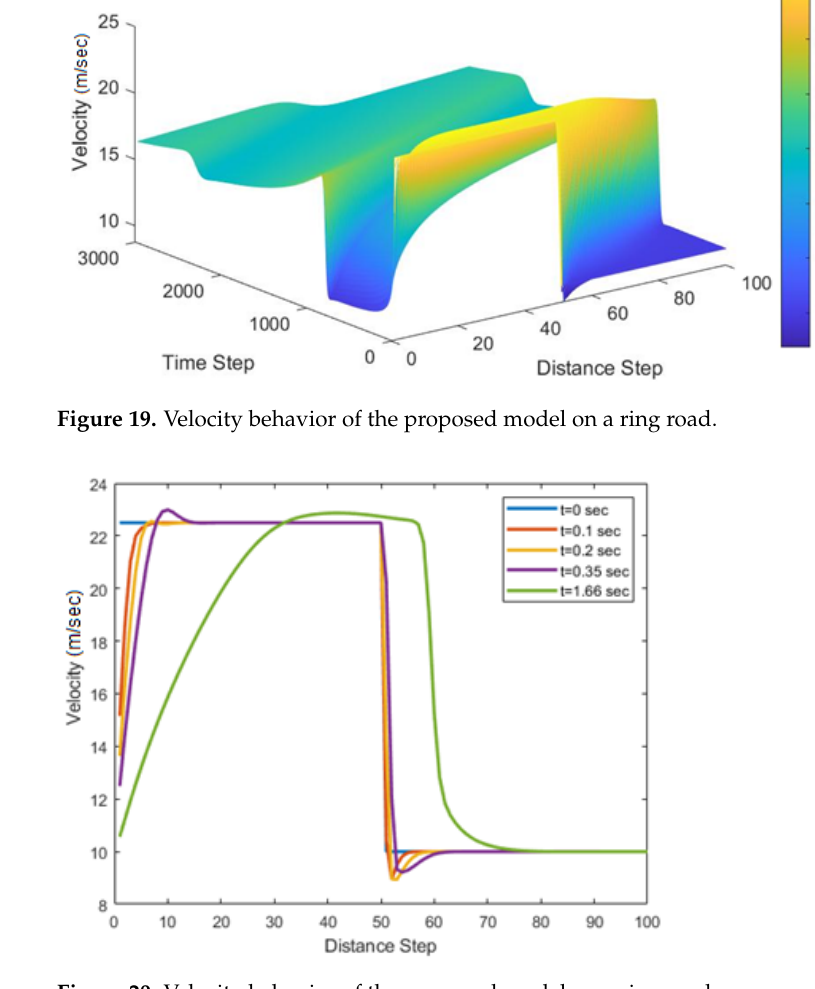
Figure 20. Velocity behavior of the proposed model on a ring road.